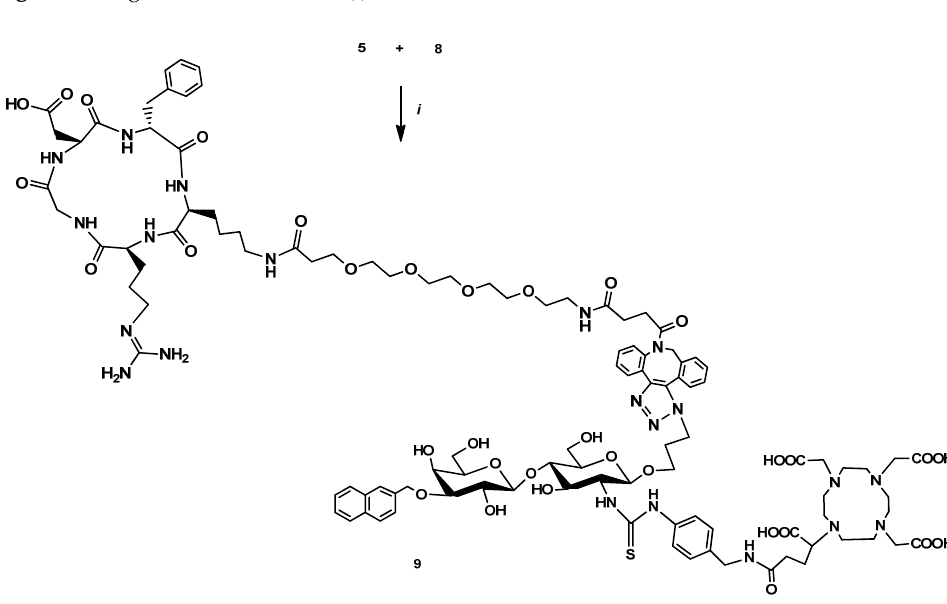
Figure 3. Reagents and conditions: (i) DIPEA, DMSO, rt, 24 h, 44.5%.